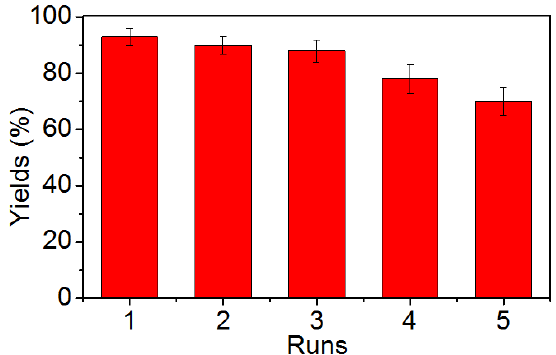
Figure 3. Recyclability tests of catalyst 1 for the KA oil oxidation towards AA with 30% H 2 O 2 . Conditions: catalyst 1 (0.02 mol %), 30% H 2 O 2 (120 mmol), DMSO (1 mmol), cyclohexanone (20 mmol), and cyclohexanol (10 mmol), room temperature for 2 h.